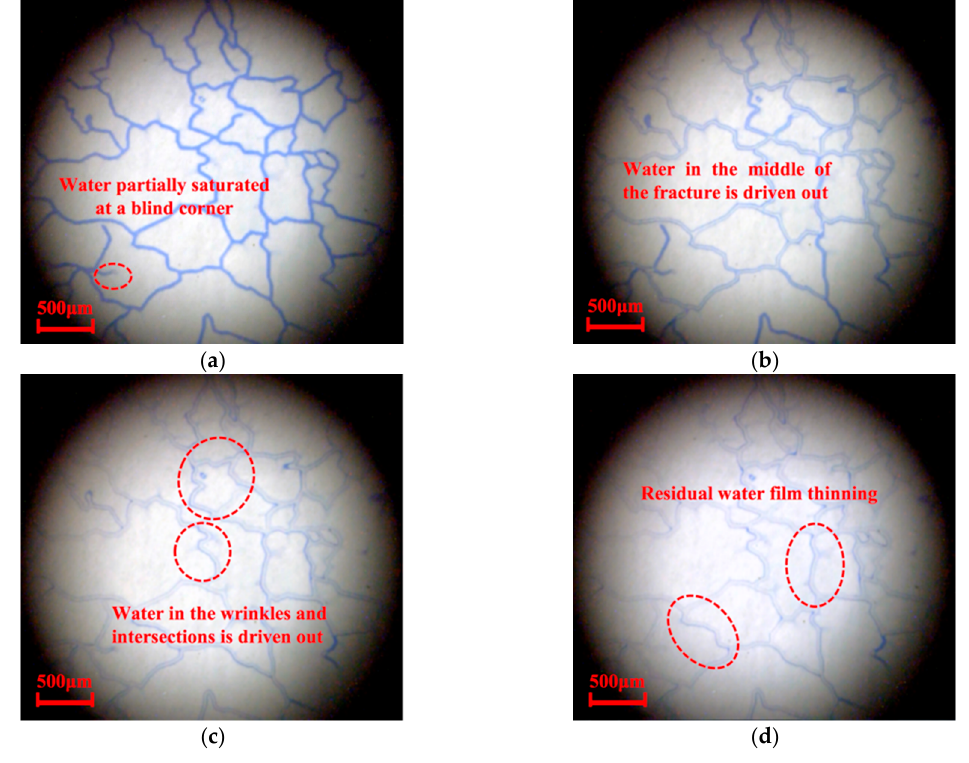
Figure 10. Gas-drive-water process of the fracture-type micromodel: ( a ) Initial stage; ( b ) Second stage; ( c ) Third stage; ( d ) Final stage.